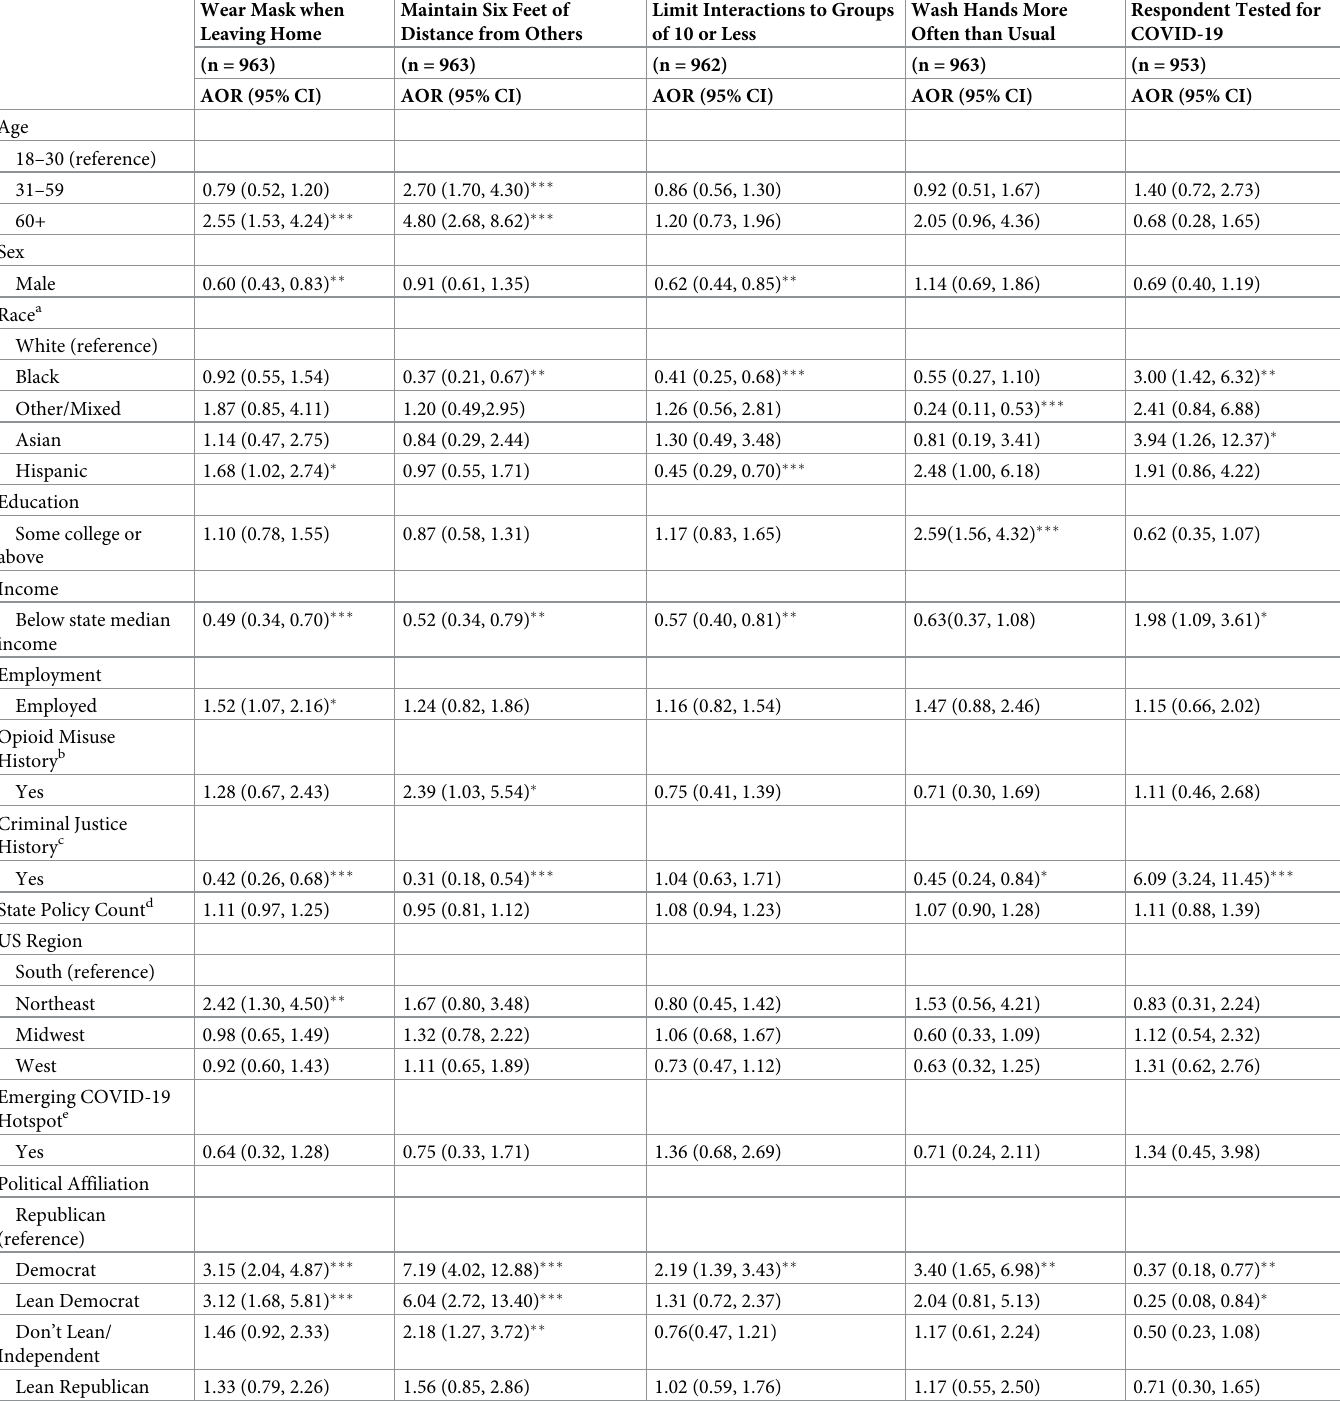
Table 3. Multivariable logistic regression for COVID-19 preventive behaviors.